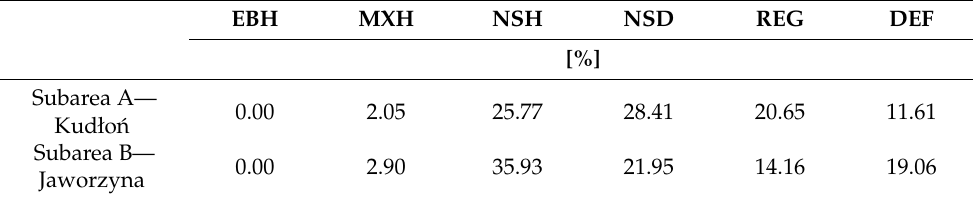
Table 6. The Dynamics Index of defined LC classes in subareas A—the Kudło´n and B—the Jaworzyna range. LC class abbreviations: EBH: healthy, forest stands dominated by the European beech;